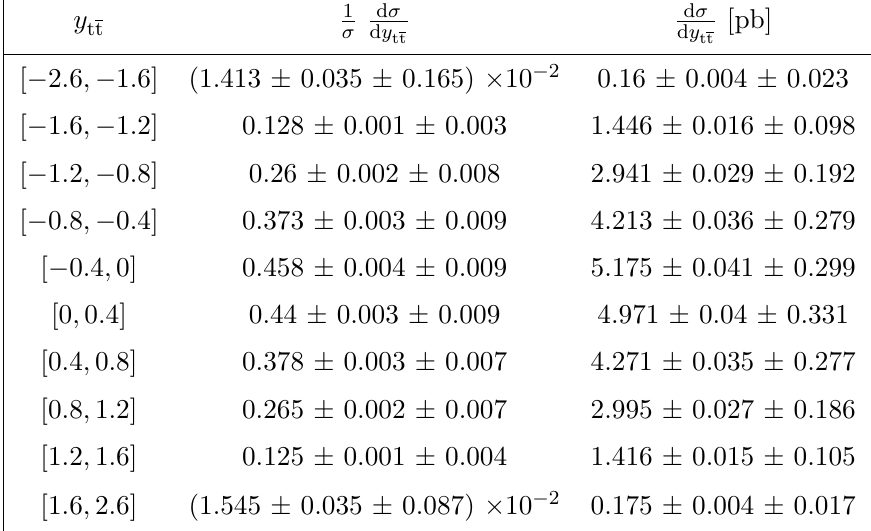
Table 25 . The measured di(cid:11)erential cross section and bin boundaries for each bin of the normalized and absolute measurements of the tt di(cid:11)erential cross section at particle level in the (cid:12)ducial phase space as a function of y are tt